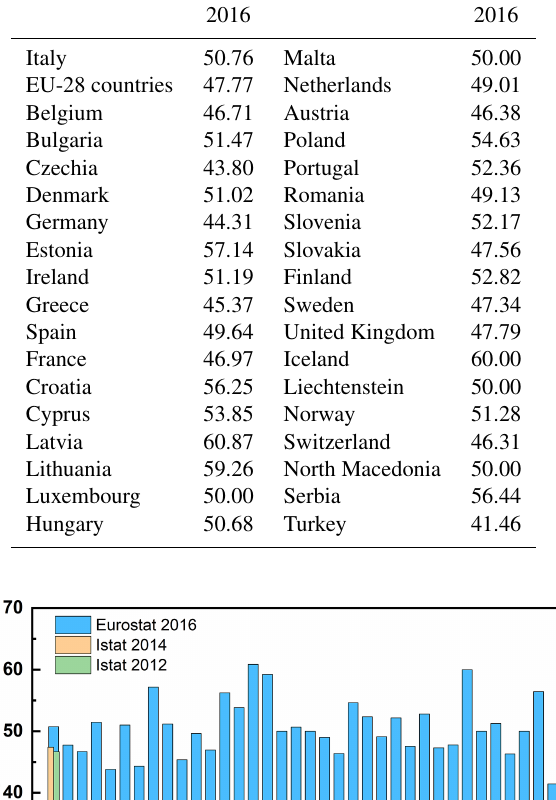
Table 1. Percentages of female Ph.D. students in European countries in 2016 (data source: EUROSTAT, https://ec.europa.eu/ eurostat/home?, last access: 31 October 2019).